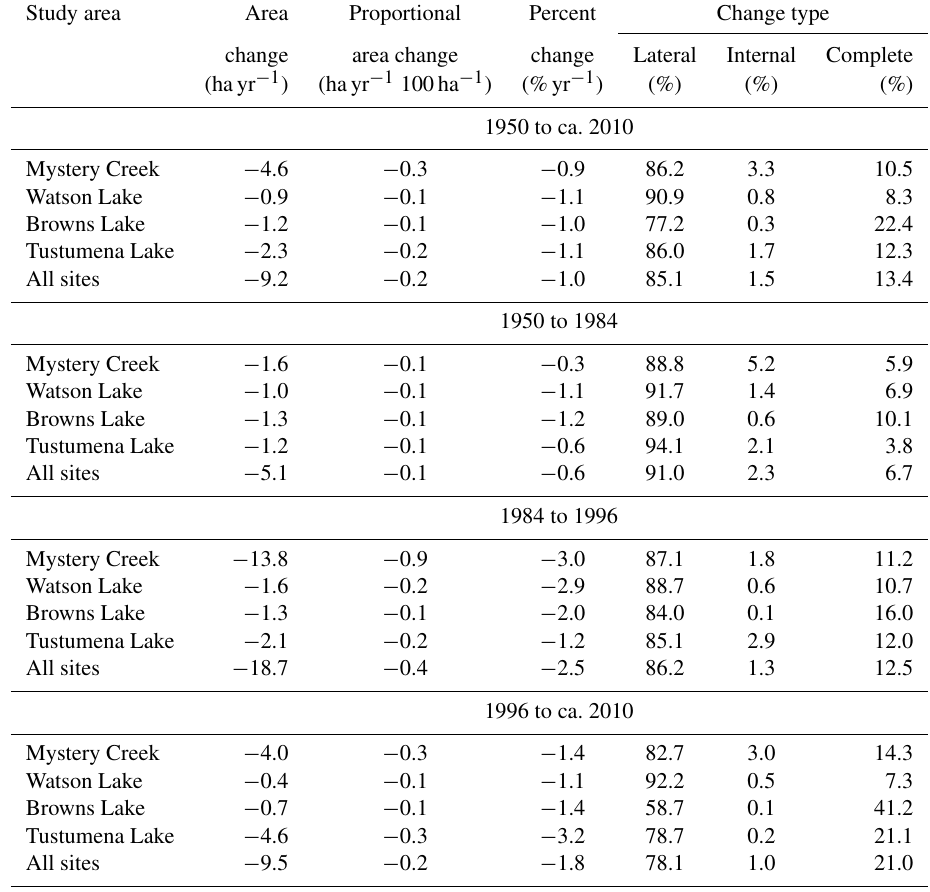
Table 3. Change in the extent of permafrost plateaus for each of the study regions between 1950 and ca. 2010, 1950 and 1984, 1984 and 1996, and 1996 and ca. 2010. Change is reported in aerial units per year, proportional area change, percent change per year, and by the type of change. Change type refers to whether the plateau loss occurred along the periphery of a feature (lateral), in the center of a feature (internal), or whether complete loss of a feature occurred. Ca. 2010 refers to images acquired in 2011 (Mystery Creek and Watson Lake), 2012 (Tustumena Lake), and 2013 (Browns Lake).